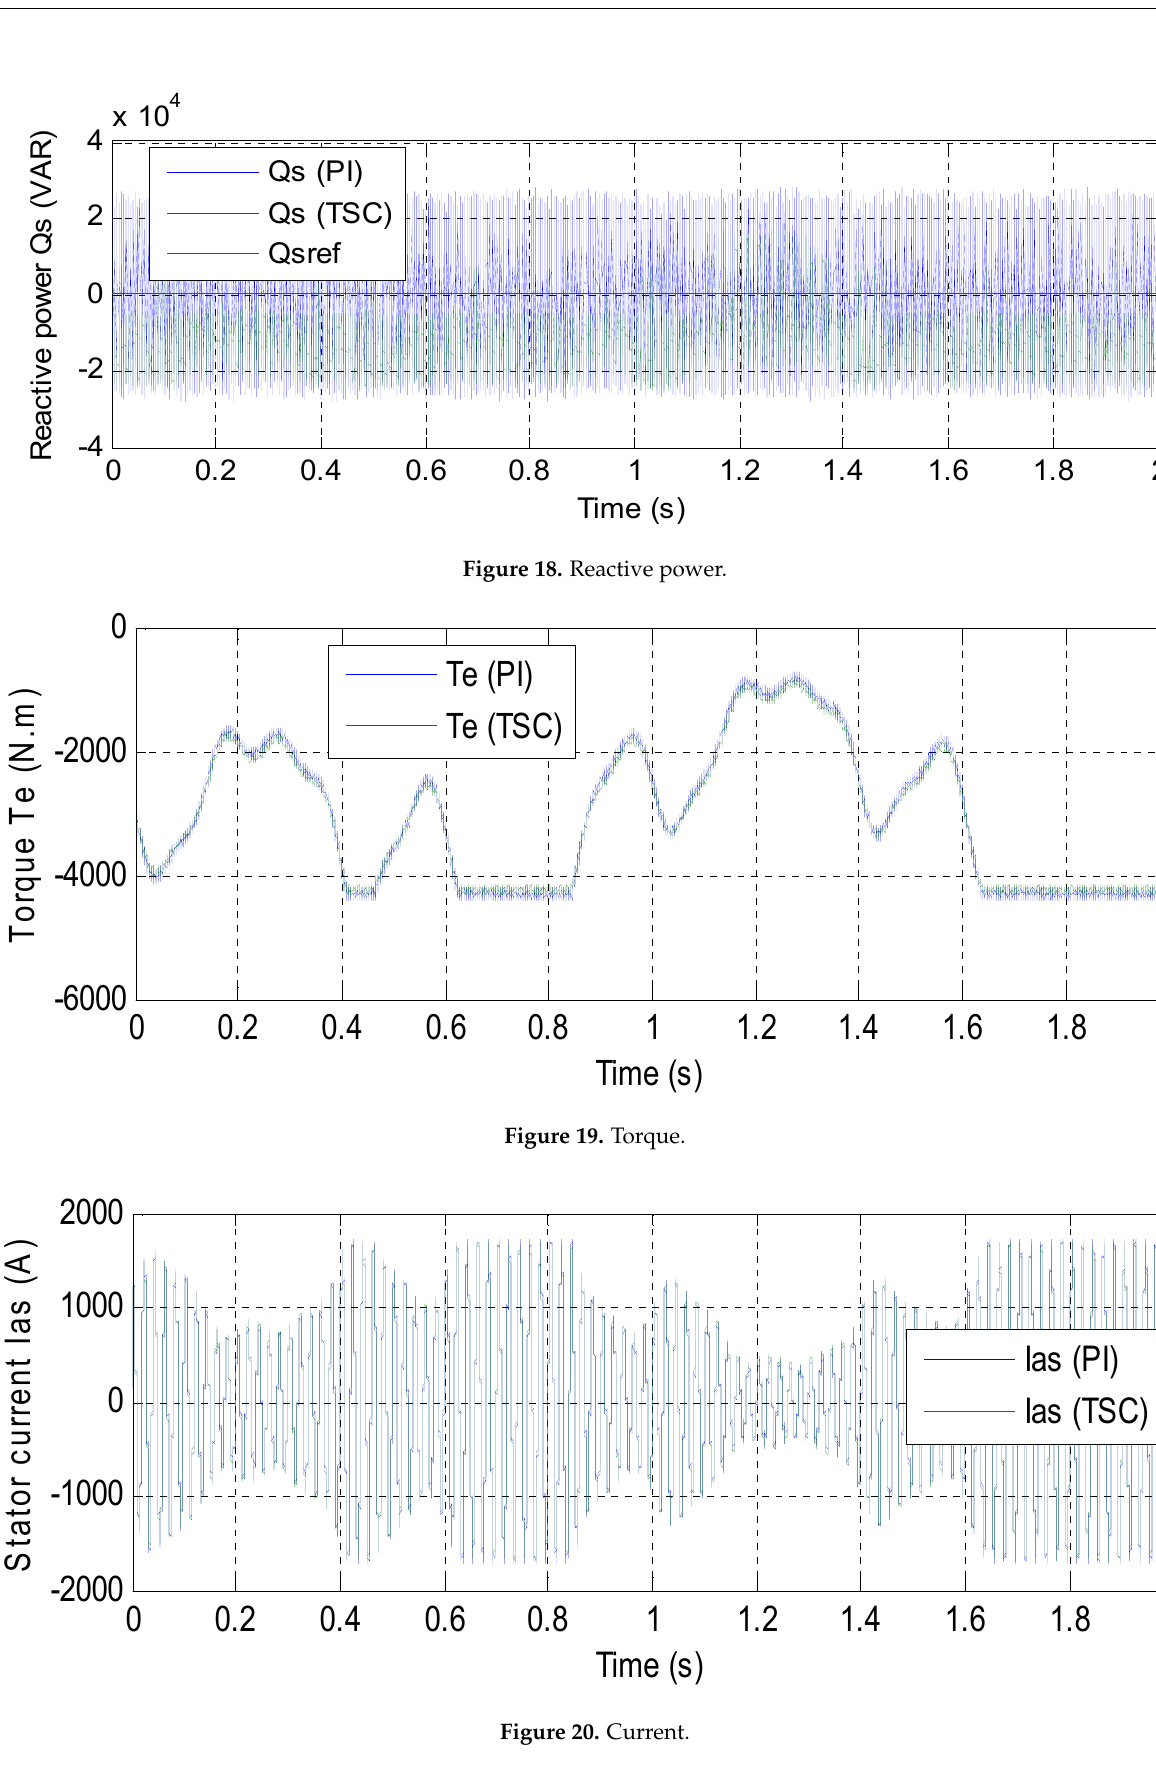
Figure 21. Zoom ( Active power).